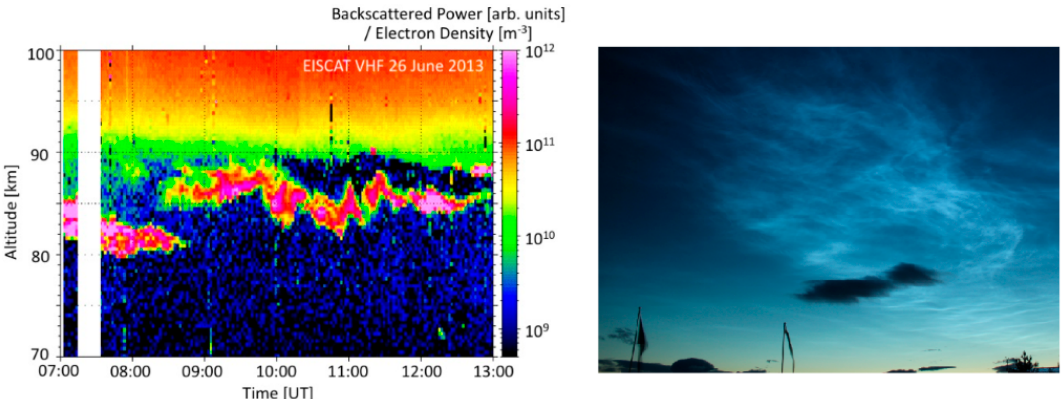
Figure 1. The polar mesospheric summer echoes (PMSE) radar echoes associated with polar ice clouds on the left [10] and optical image of Noctilucent clouds (NLC) on the right.